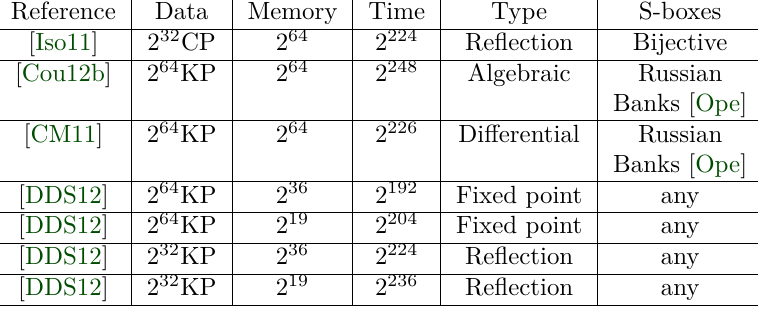
Table 4: Single-key Attacks on the Full